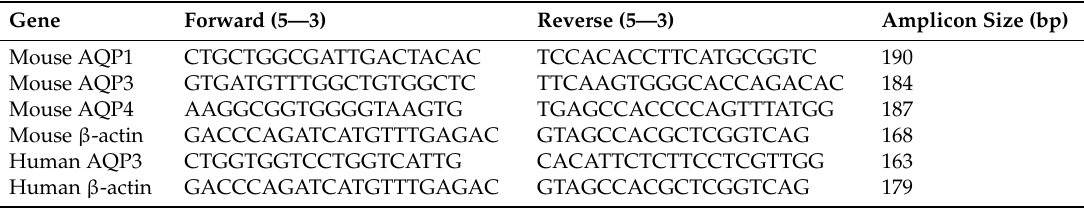
Table 1. Primer sequences of